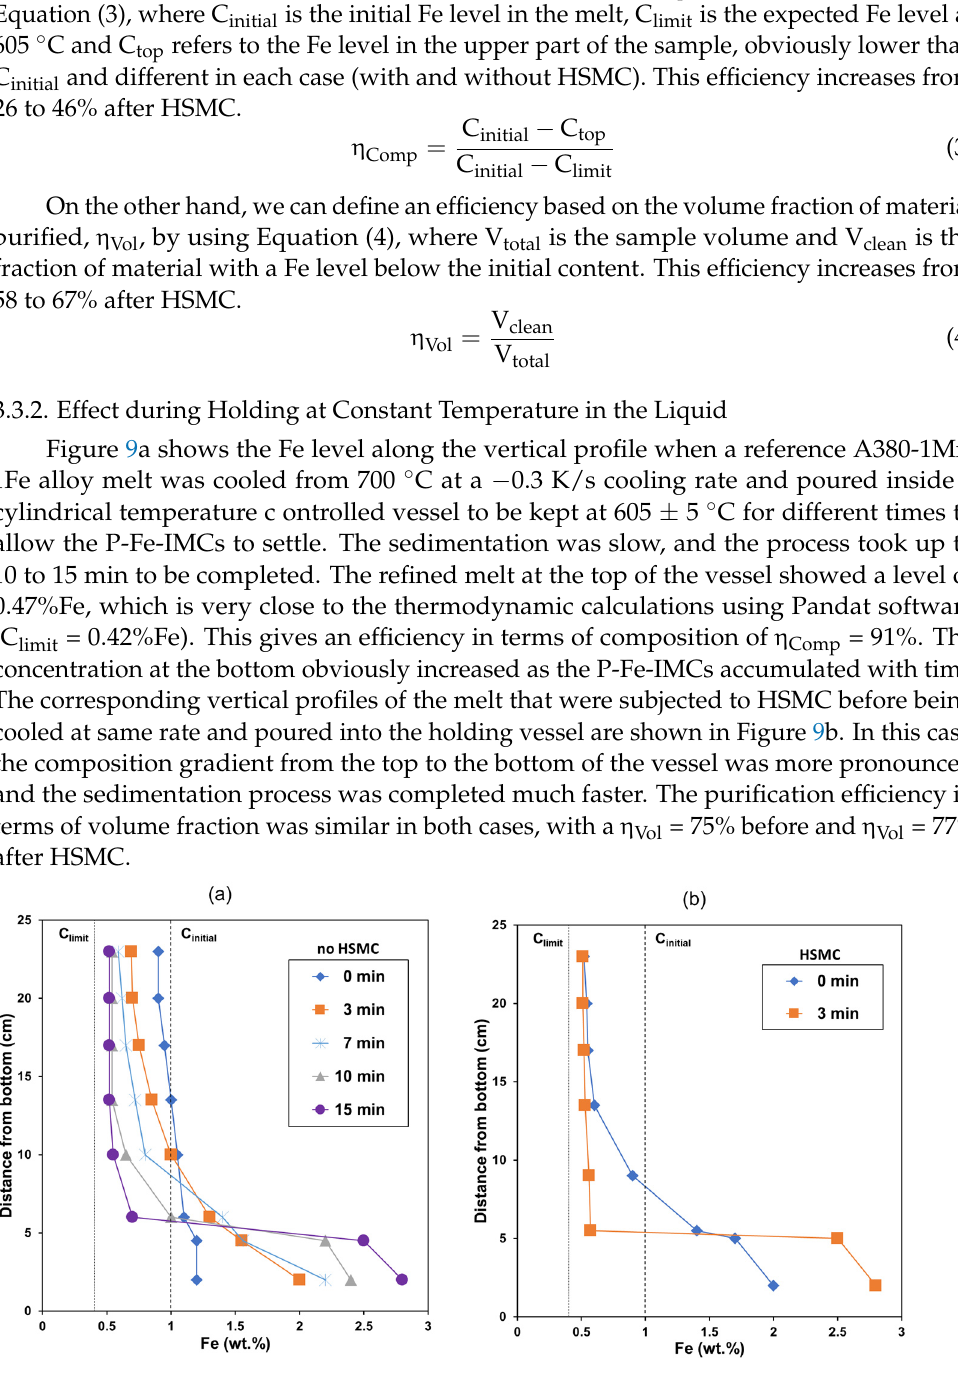
Figure 9. Sedimentation of Fe-rich intermetallics in A380-1Fe-1Mn alloy melt during holding at 605 °C for different times in a preheated cylindrical vessel. ( a ) Without melt treatment and ( b ) after using the HSMC technology in batch processing mode.